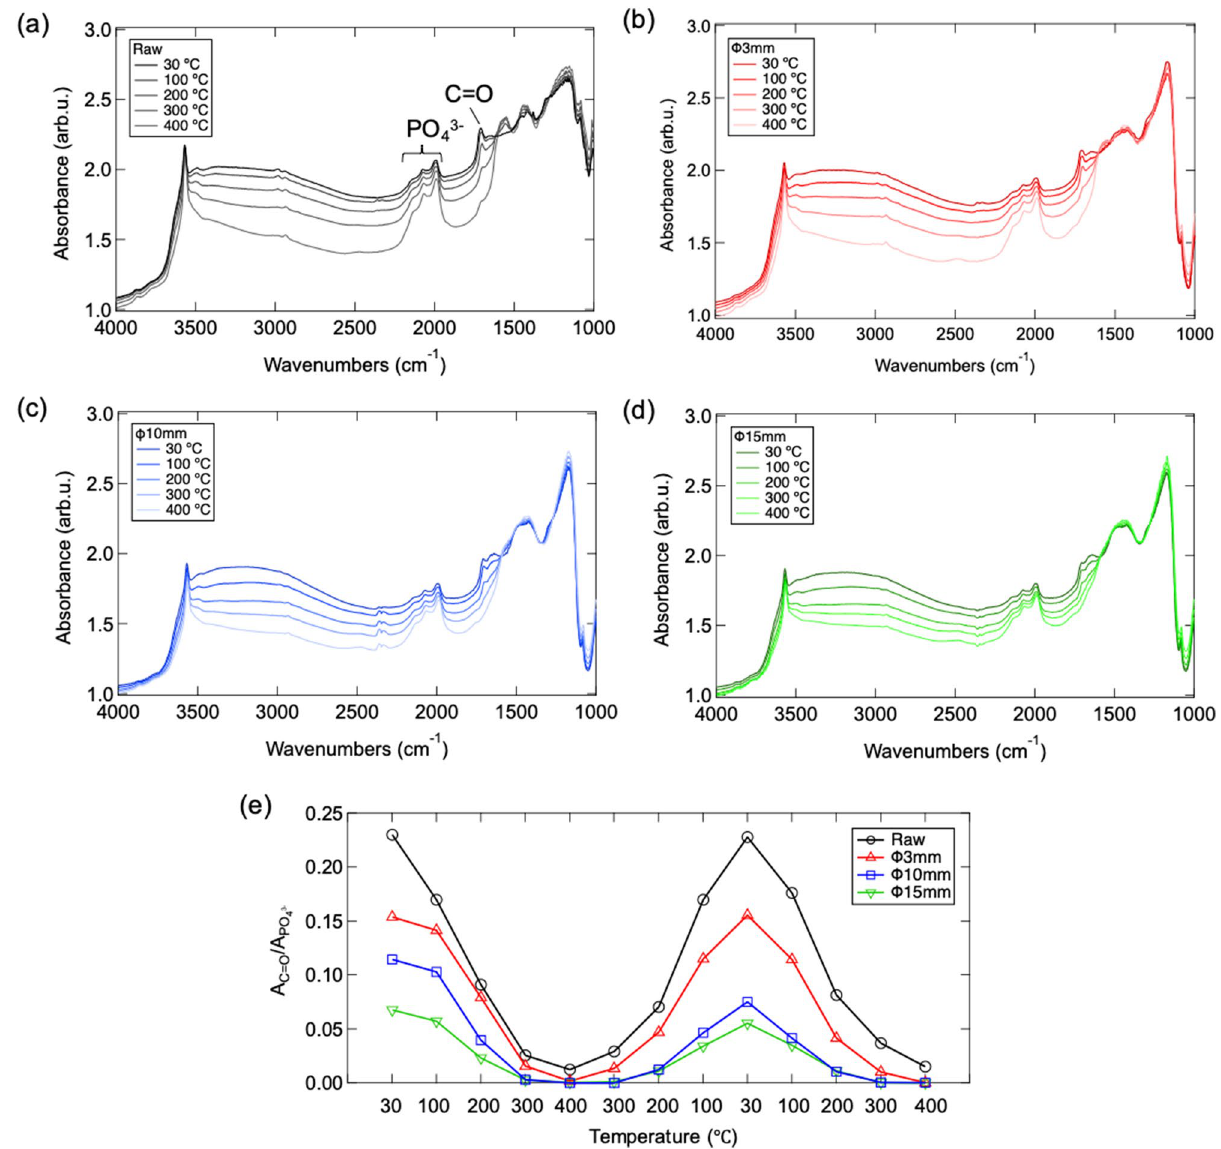
Figure 7. DRIFT spectra of ( a ) raw and mechanochemical treated HAp via ( b ) 3 mm, ( c ) 10 mm and ( d ) 15 mm balls under in-situ flow of ethyl acetate when temperature increasing from 30 to 400 °C and ( e ) summarized temperature-dependent integral peak area ratio of C=O/PO 43− in cycled temperature increasing, decreasing and re-increasing